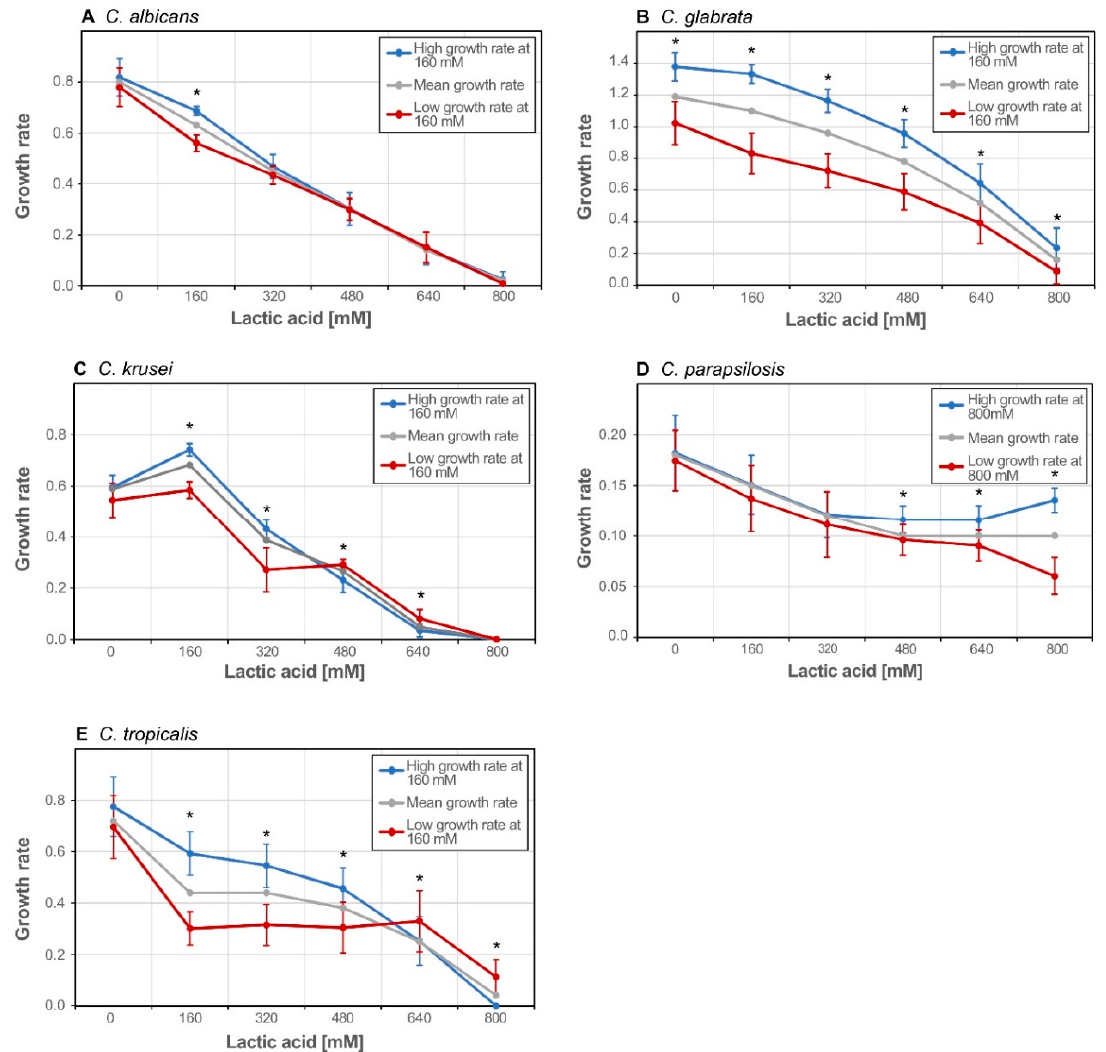
Figure 2. Cluster analysis of lactic acid stress response on Glucose. Isolates were sorted according to their growth rate at 160 mM lactic acid if not stated otherwise and put into high (blue line) and low (red line) growth rate clusters; ( A ) C. albicans ; ( B ) C. glabrata , ( C ) C. krusei ; ( D ) C. parapsilosis , sorted according to the growth rates at 800 mM; ( E ) C. tropicalis ; Grey line represents the average growth rate per concentration; Error bars represent the standard deviation of the growth rate in a cluster. Asterisks represents statistical difference of one condition to the next lower lactic acid concentration (* p ≤ 0.05).